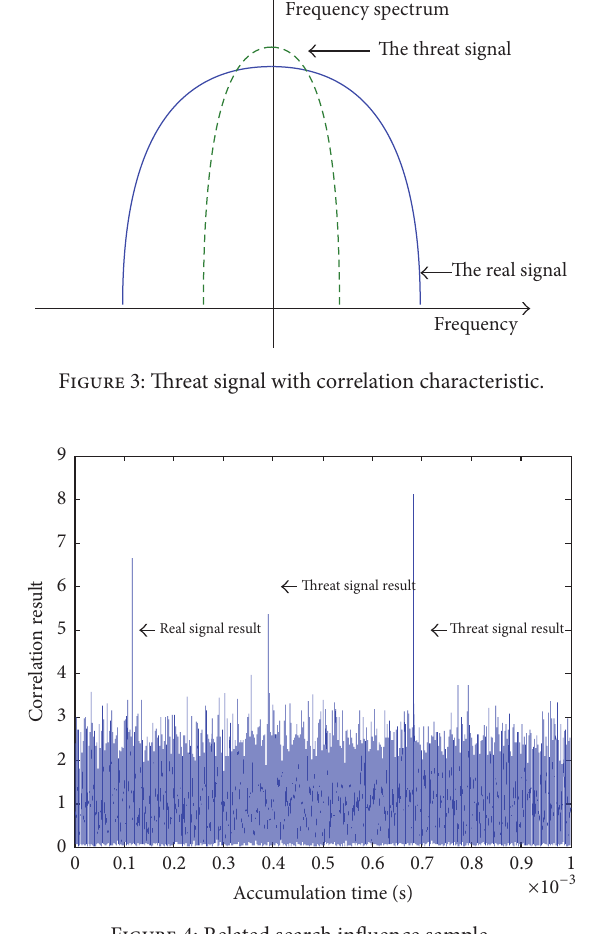
Figure 4: Related search influence